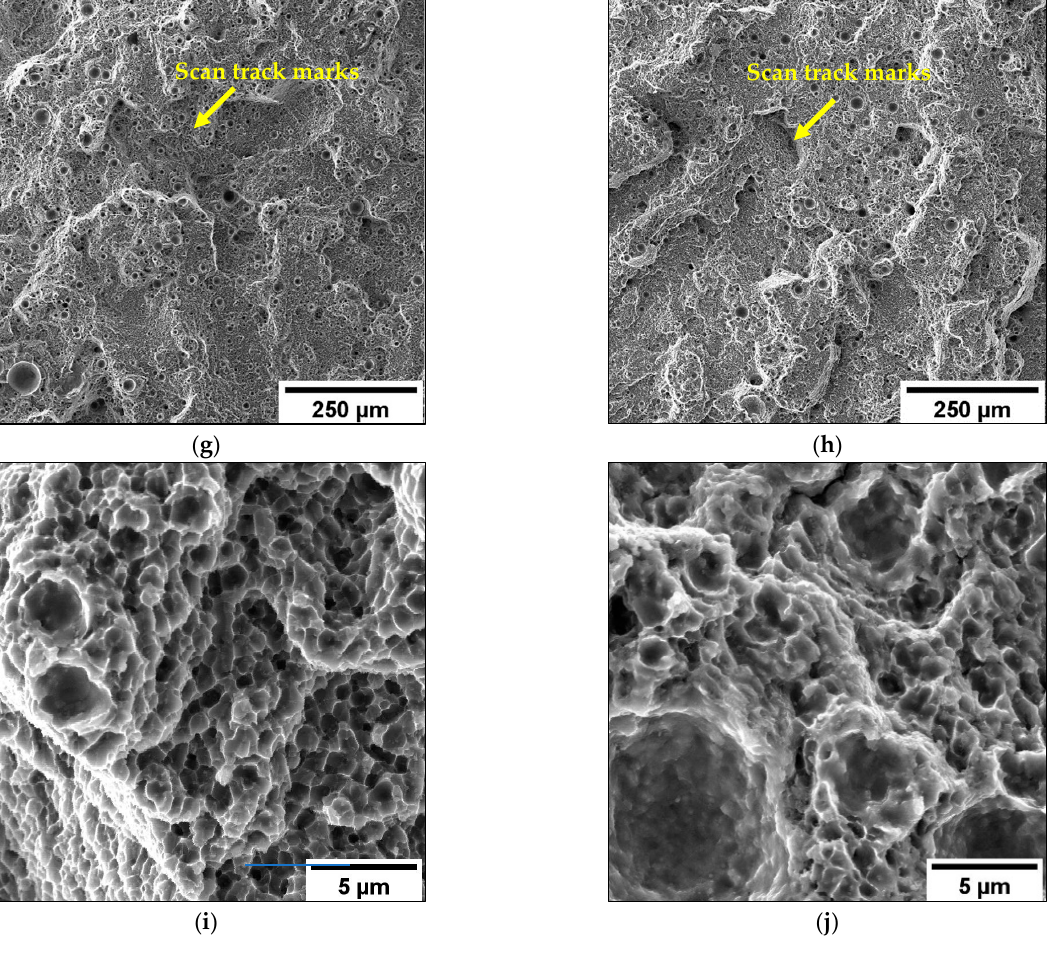
Figure 12. SE image of T5 ‐ RT ( a , c , e , g , i ) and T5 ‐ 200T ( b , d , f , h , j ) specimens. Killer defect ( a , b ); crack propagation region ( c , d ); micro ‐ tearing in the fatigue propagation region ( e , f ); final overload fracture ( g , h ); dimple voids ( i , j ). Yellow arrows indicate parabolic stripes close to the defects in the fatigue crack propagation regions and scan track marks in the overload fracture zone. Dotted white arrows indicate the direction of crack propagation.